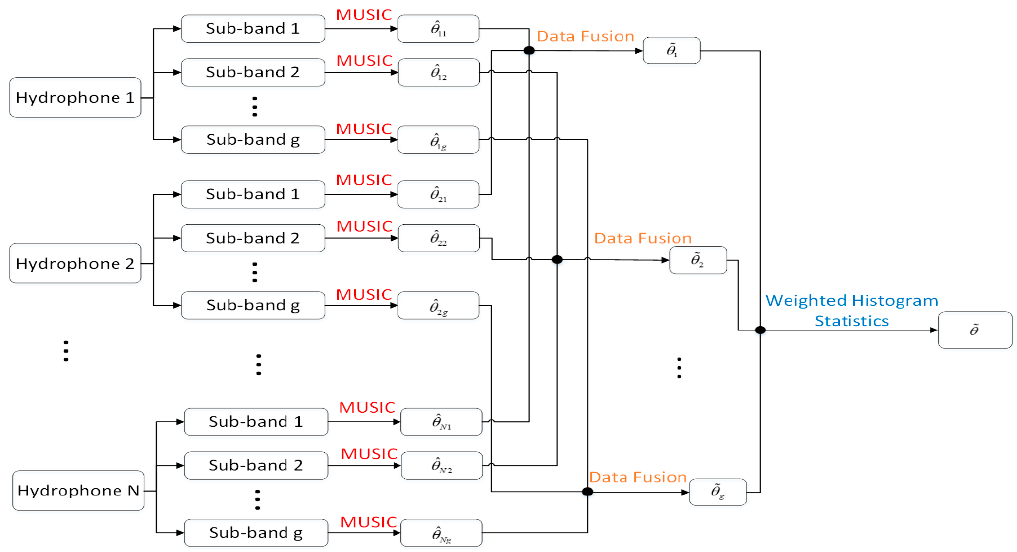
Figure 5. Flow diagram of the data fusion orientation method based on the weighted histogram statistics (DF-WHS).